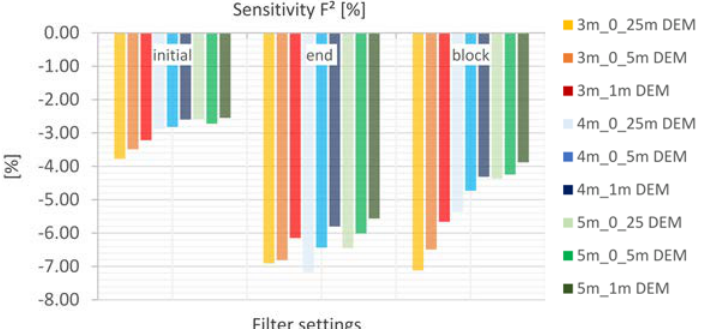
Figure 38. Comparison of the model sensitivity (S-F 2 ) for the filter settings and the evaluated mesh